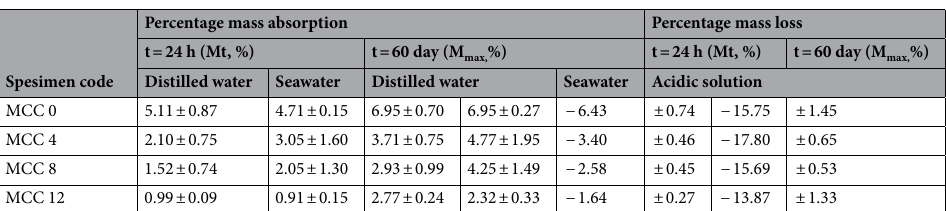
Table 4. Percentage of water absorption and mass loss of